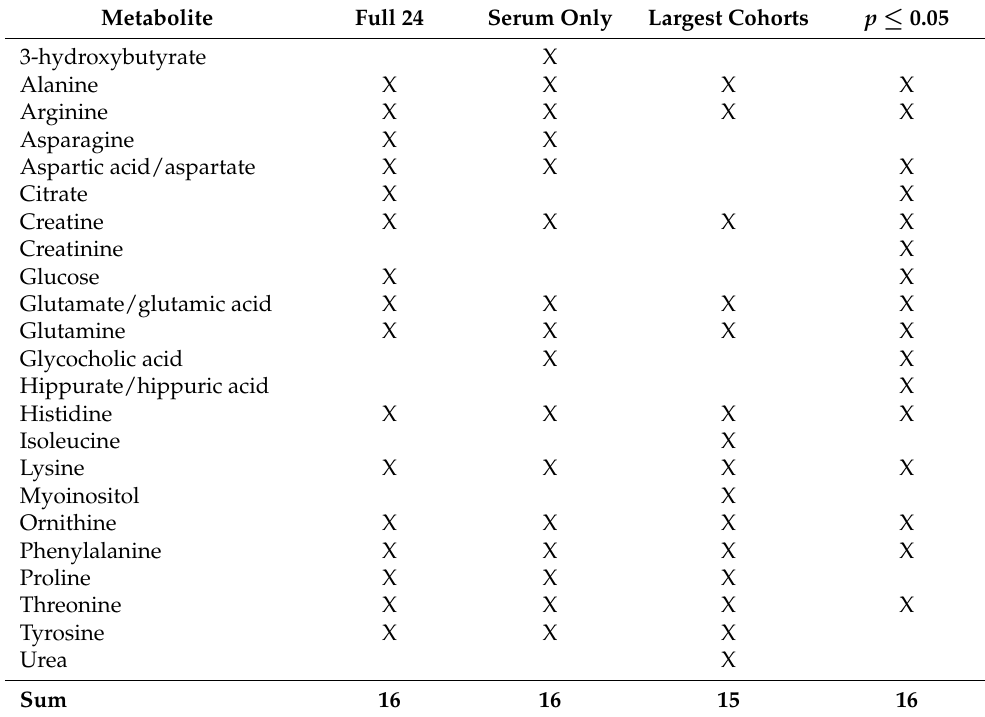
Table 4. Common metabolites within study